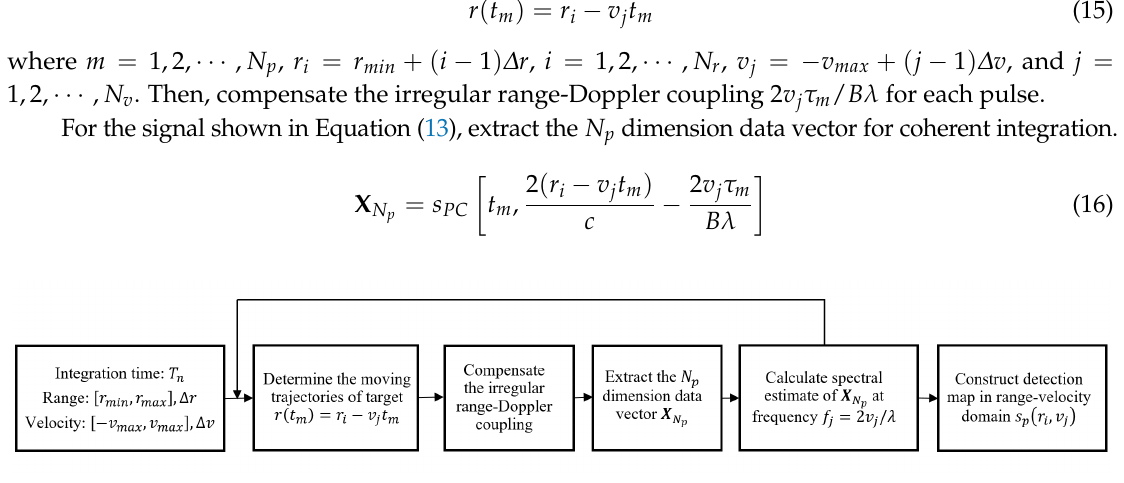
Figure 7. Flowchart of the proposed method.